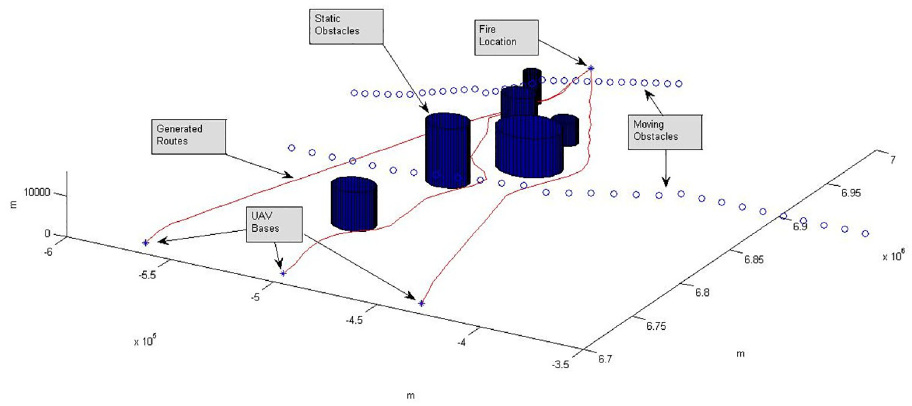
Fig 2. Router calculates three UAV routes commencing from three UAV locations (bases) to a single fire area, while avoiding six static hazards and two moving objects. The work in [23] uses geodetic coordinates for route generation which is converted to Cartesian coordinates for simplicity of calculations and resulting plots. The interested reader may refer to [23] for further details. All axes show length in meters.